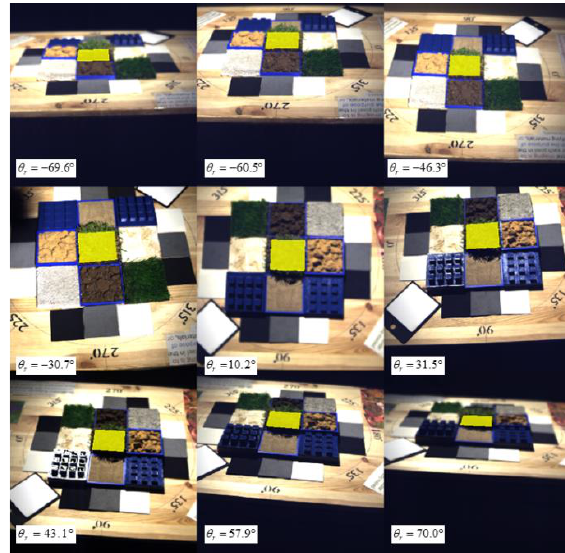
Figure 5 . An example of a sampled ROI on the near-vertical image ( 10 . 2 ) for the landcover type Grass, and the corresponding ROIs on the other images on the profile of 90 to 270 degrees, as obtained by the proposed automatic tracking strategy.